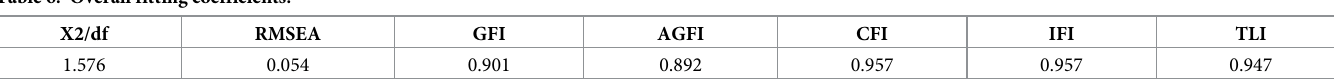
Table 6. Overall fitting coefficients.